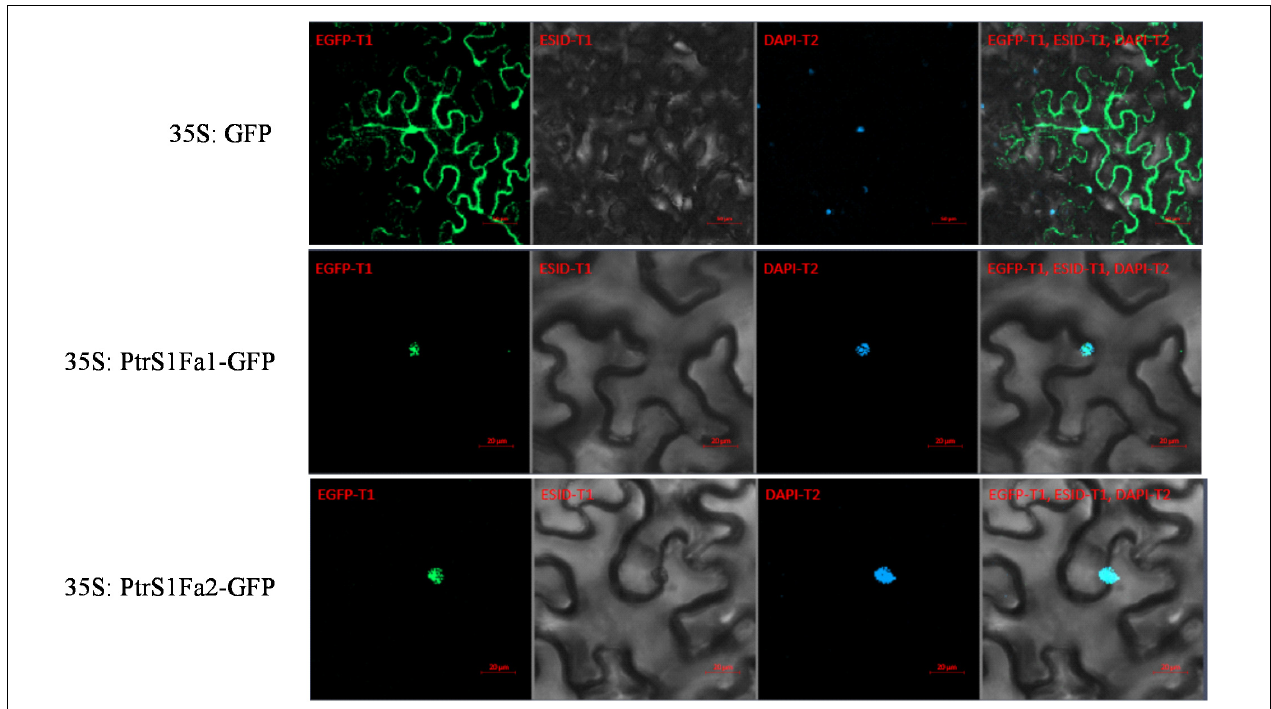
FIGURE 5 | Cellular localization of the S1Fa-like protein. The constructs 35S: S1Fa 1-GFP, 35S: S1Fa 2-GFP, and 35S:GFP were, respectively, transformed into leaves of tobacco using Agroinfiltration; DAPI: staining of nuclei using DAPI; GFP: detection of GFP fluorescence; merge: the images of brightfield, DAPI staining, and GFP were merged together; ESID: